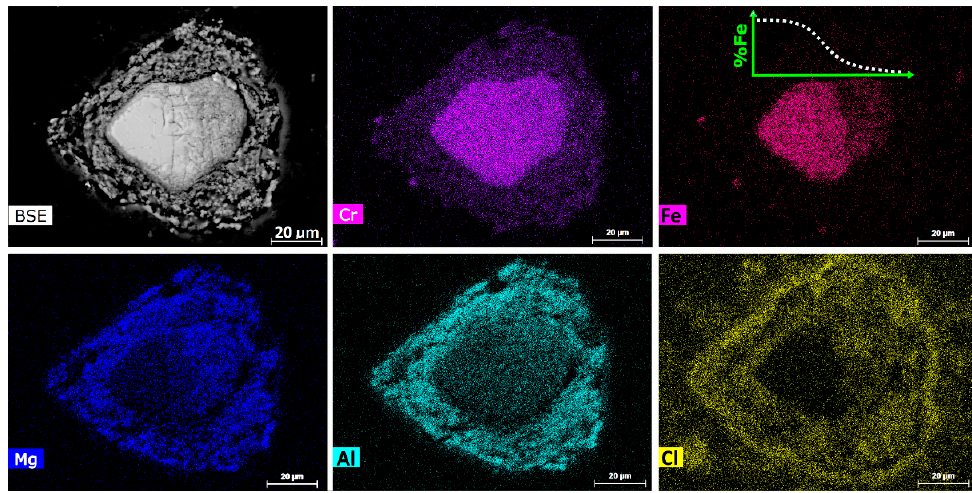
Figure 17. BSE and elemental mapping of a partially reduced chromite.